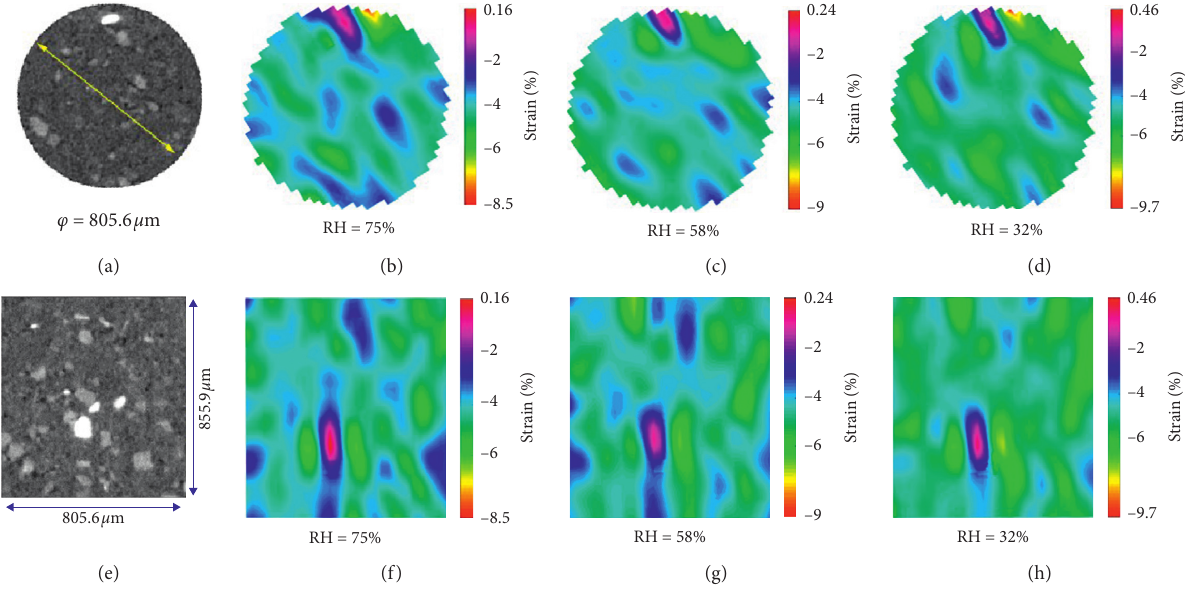
Figure 6: Strains ( ε xx ) in sections A-A and B-B during drying: (“+” means dilatation and “